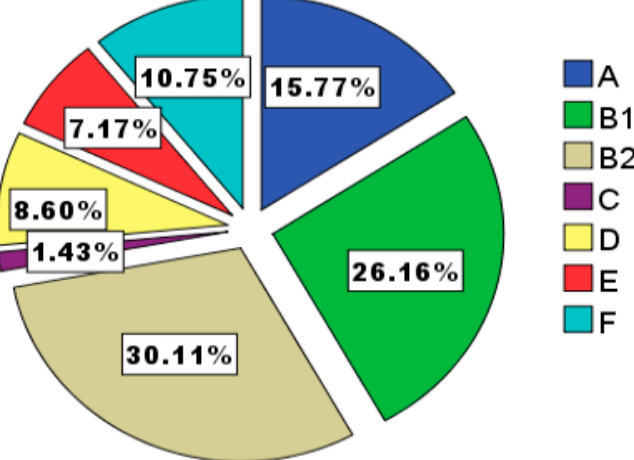
Figure 1. Phylogenetic group distribution (including group A, B1, B2, C, D, E, and F) of E. coli in the anal swabs of dogs.